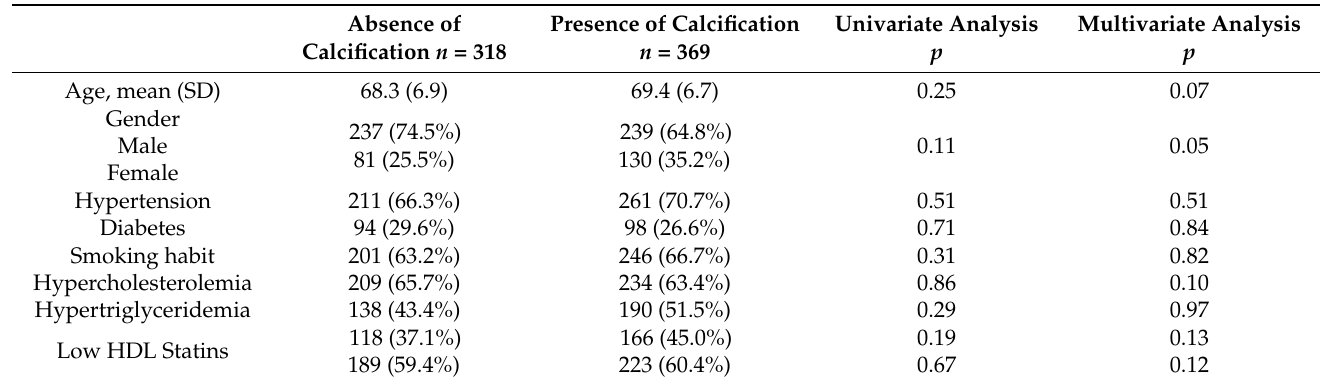
Table 2. Correlation between the presence of calcifications and risk factors